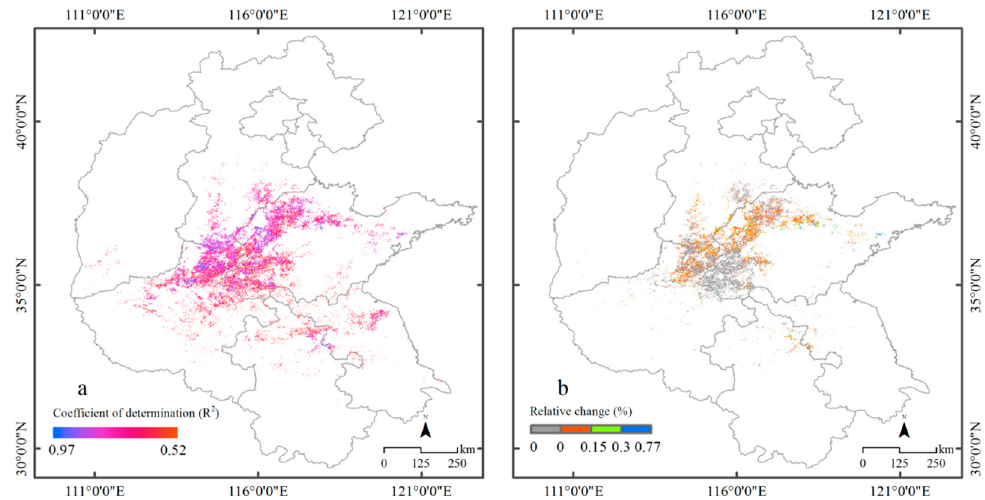
Figure 11. Spatial distribution of the determination coefficient (R 2 ) of the multiple linear regression model between GUD and climatic factors for the period of 2001–2015, considering time lag effects ( a ), and ( b ) its relative change compared with ignoring the time lag effects.